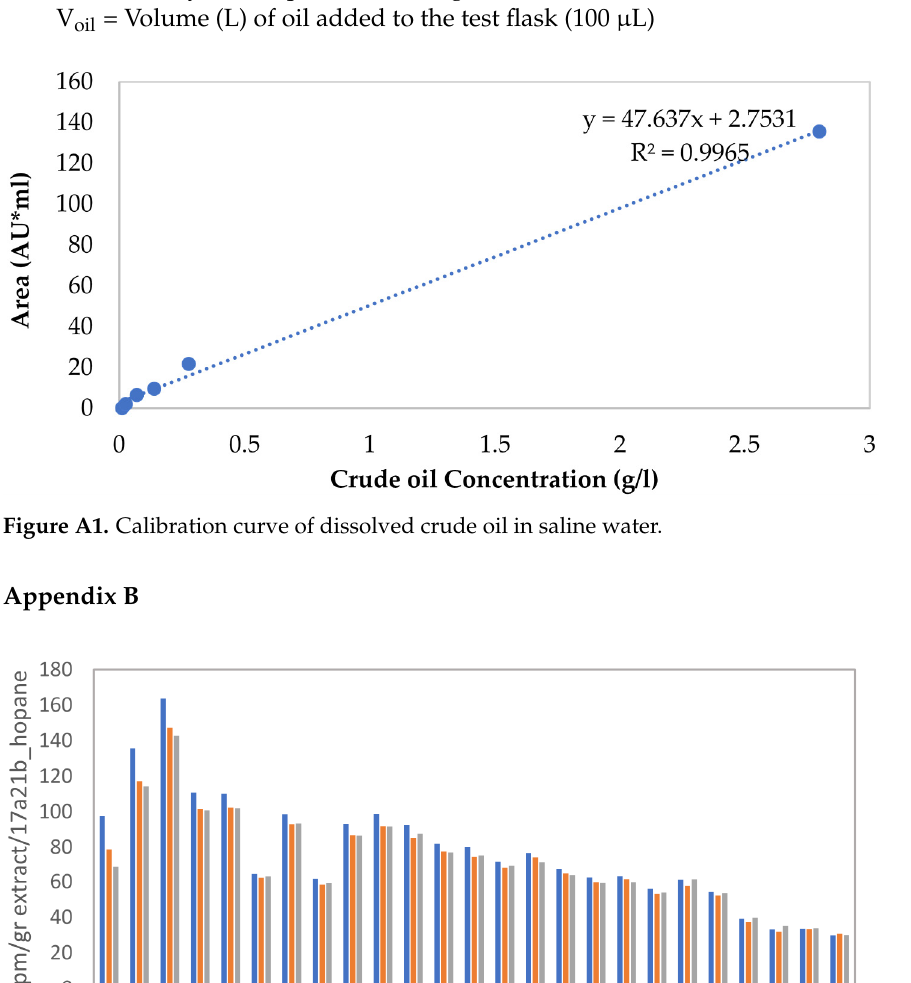
Figure A3. Bioremediation test results. Saturated hydrocarbons concentration after 7 days of bio- remediation. (a) SW_CO: Sea water with crude oil. (b) SW_CO_SOY: Sea water, crude oil and